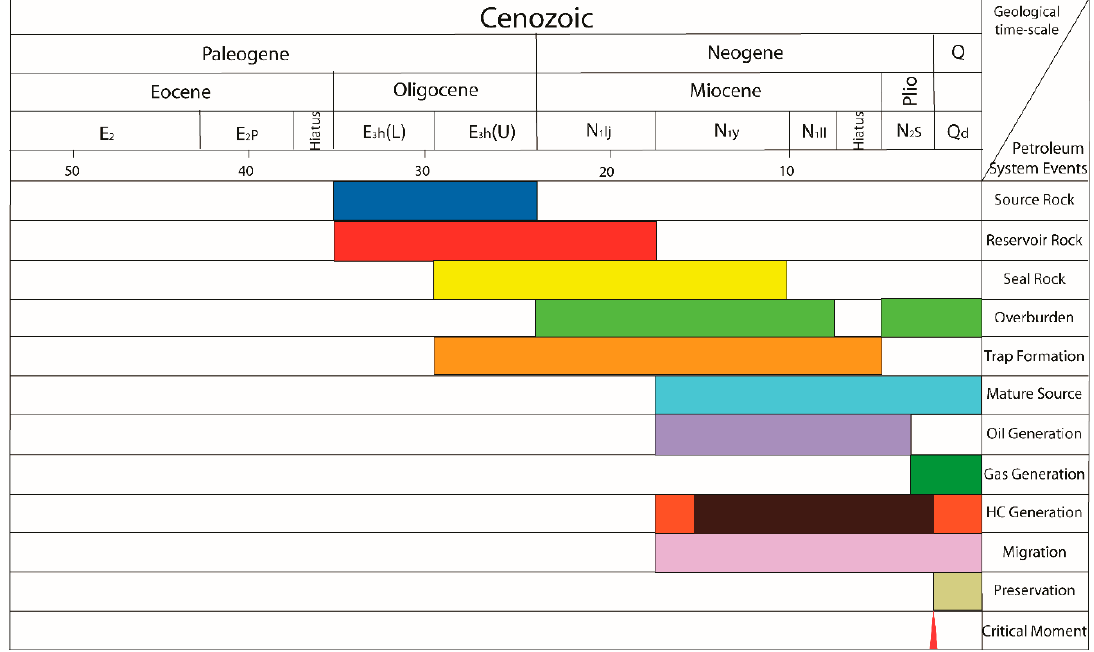
Figure 9. Event chart of the Huagang–Huagang Petroleum System (?) in the Xihu Sub-basin.